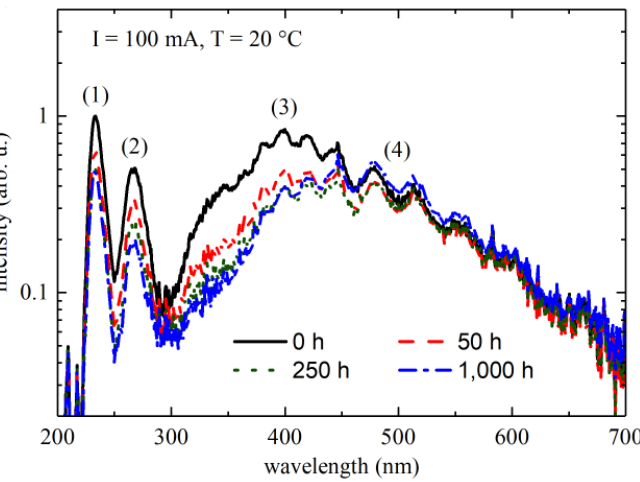
Figure 8. Emission spectra for different operating taken at 20 °C and 100 mA. Reproduced with permission. [36] Copyright 2018, IOP Publishing.